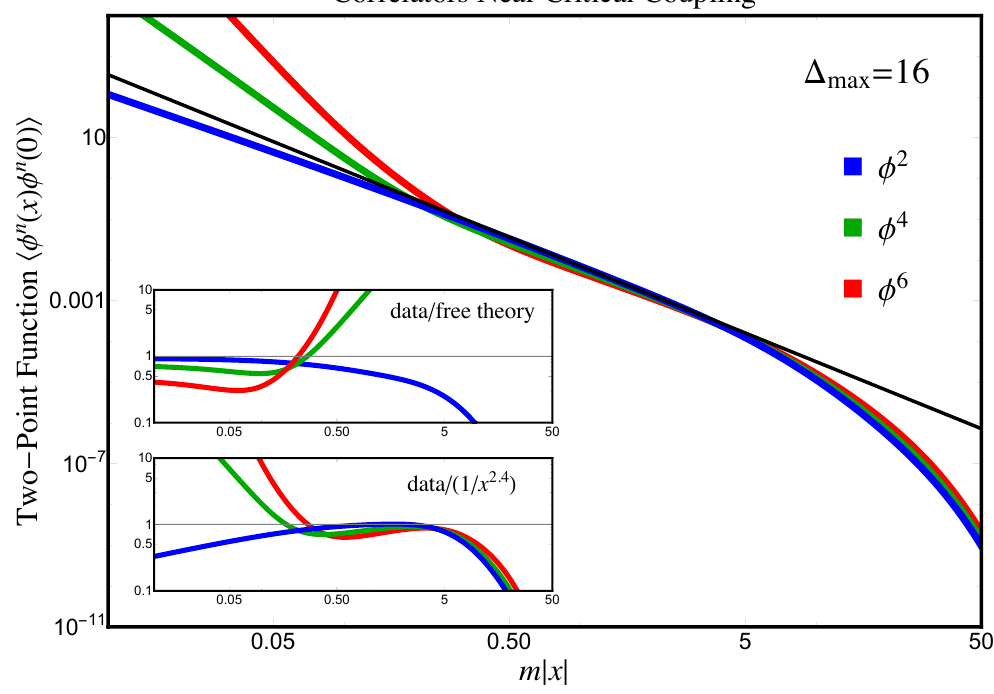
Figure 11 . Position space two-point functions h φ n ( x ) φ n (0) i for n = 2 , 4 , and 6 near the critical coupling ( ¯ g = 1 . 05 ). Solid black line shows the fit in the region 1 ≤ m | x | ≤ 4 , given by 0 . 007 . Top | x | 2 . 4 inset shows the ratio of the correlators to the free theory correlators, given by n ! . Bottom (4 π ) n | x | n inset shows the ratio of the correlators to the power law fit. The extracted exponent 2 . 4 is within 20% of the 3d Ising prediction 2∆ 2 . 83 . In comparing to the fit in the bottom inset, we have (cid:15) ≈ rescaled the data by an overall constant for visual